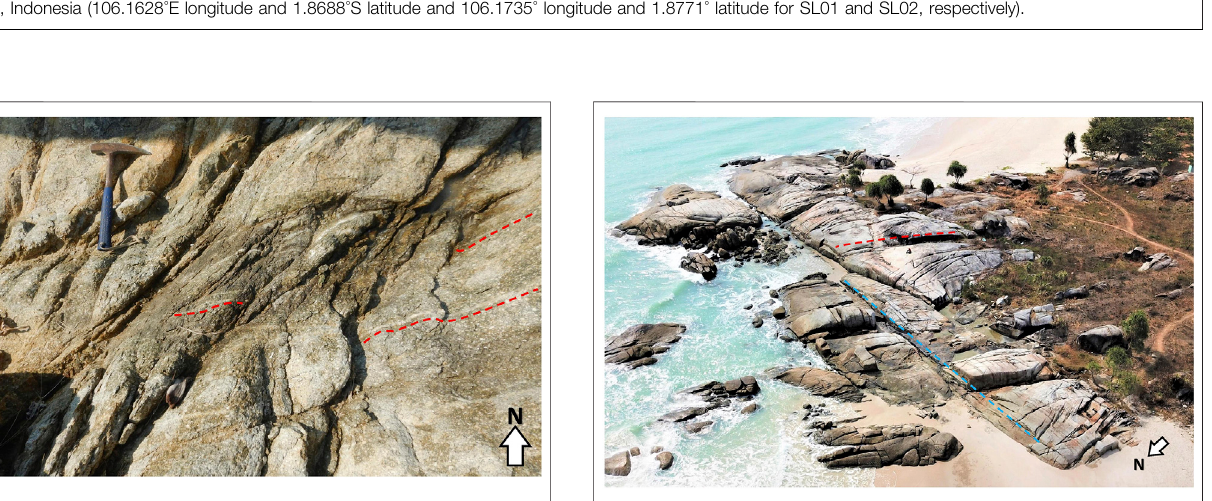
FIGURE 2 | Detailed picture of the fracture network on SL01 with the handle of the hammer pointing south. Fractures on the outcrop are mainly trending E-W and NE-SW; fi ne-sized fractures are very common, trending E-W (marked with red dashed line).